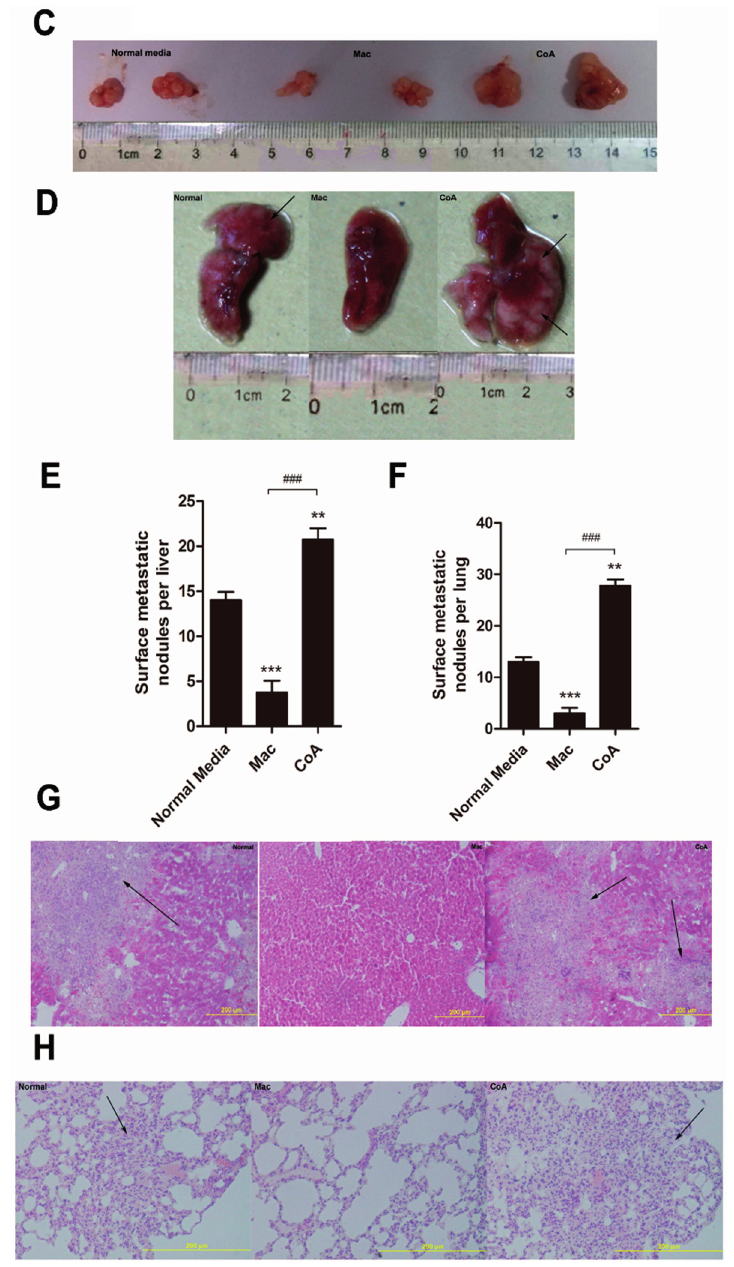
Figure 2. In vivo tumorigenicity and metastatic assay. ( A ) Growth curves for tumors generated by MCF-7 cells grown in three types of conditioned media. The width and diameter of each tumor were measured using calipers, and tumor volume was calculated using the formula ½ × a × b 2 , where “a” is the longer tumor axis and “b” is the shorter tumor axis; ( B ) Tumor weight was measured after excision from mice, n = 5; ( C ) Images of tumors from the three groups of mice; ( D ) Macroscopic view of nodules in the lungs from the three groups of mice; ( E , F ) Quantification of the metastatic nodules in the three groups of mice ( n = 5); ( G , H ) Hematoxylin-eosin (HE) staining of paraffin sections from livers and the lungs of the three groups of mice. Metastases are indicated by the black arrows. ** p < 0.01, *** p < 0.001 vs. Normal media group; ### p < 0.001 vs. Mac